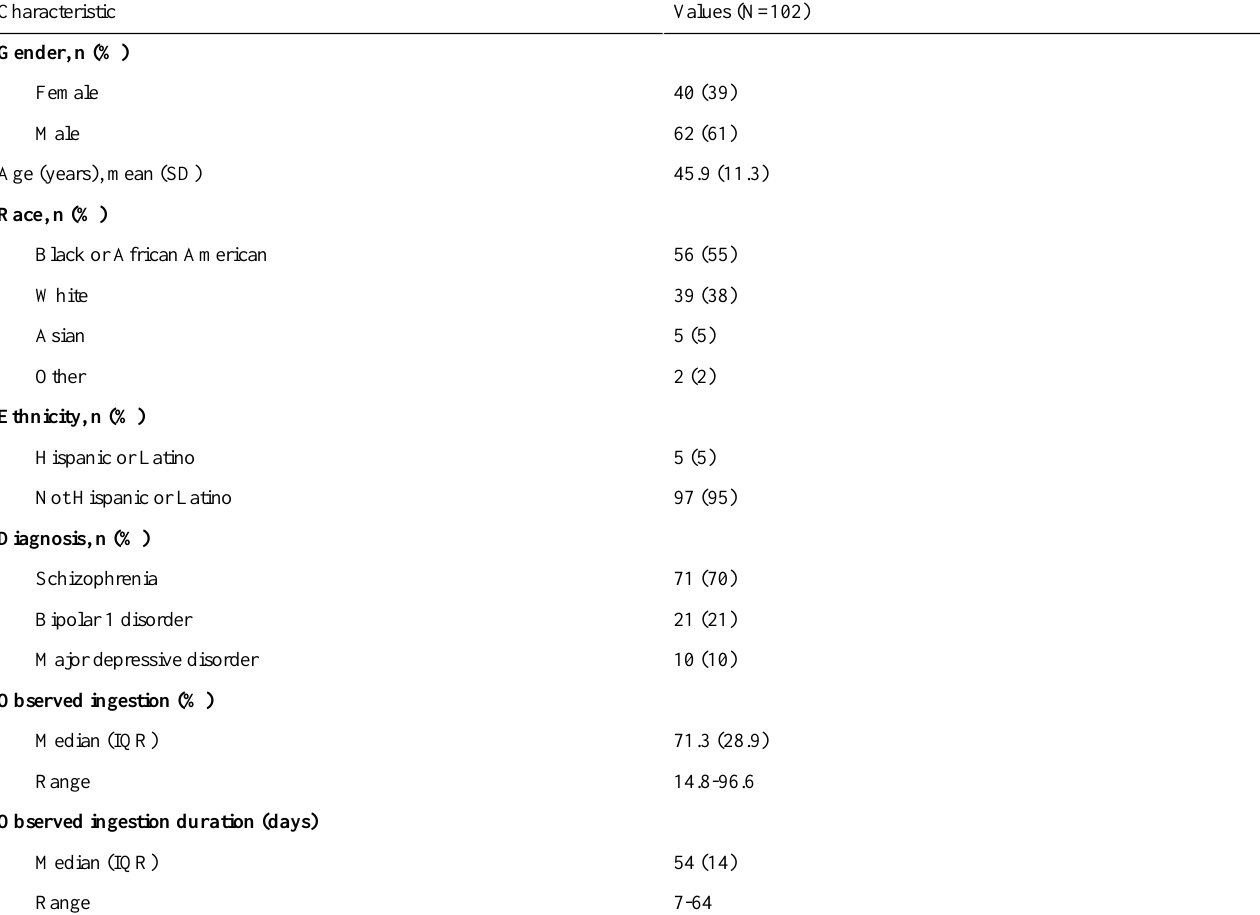
Table 1. Demographic and clinical characteristics of the sample